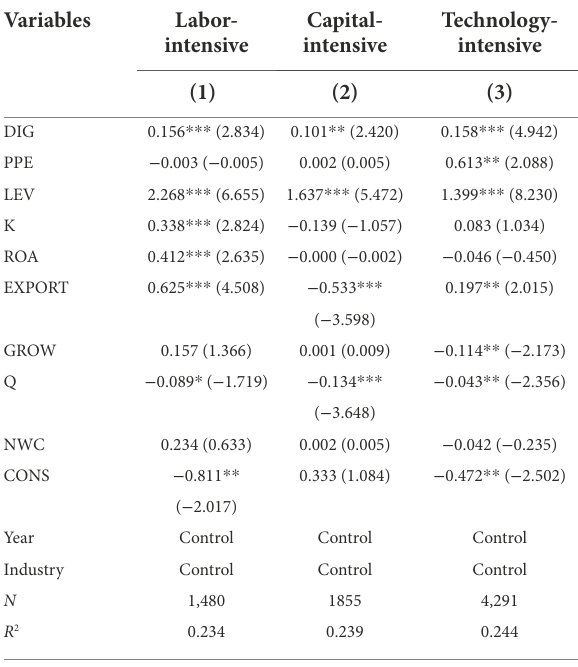
TABLE 10 Regression results for different factor intensities.